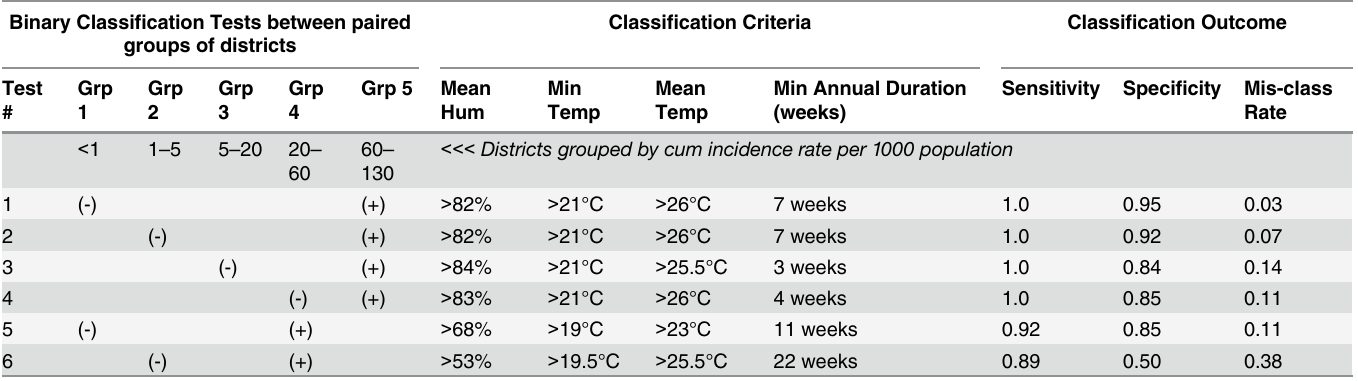
Results of weather-based classi fi cation comparing paired high (+) versus low (-) incidence groups of dengue-positive districts according to cumulative incidence rates per district for 2005 – 2012. Classi fi cation tests examine the degree to which weather conditions alone differentiate between high versus low incidence rate category of districts. Criteria producing lowest misclassi fi cation rate is shown for each pairing. Note that humidity was not a signi fi cant factor in determining dengue positive/negative districts in Table 1, however humidity was necessary to differentiate high versus low incidence magnitude among dengue positive districts. Classi fi cation criteria for a test represent concurrent weather